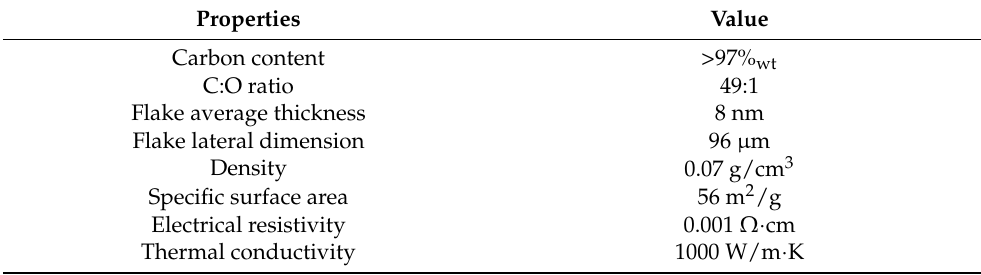
Table 2. GnP features.